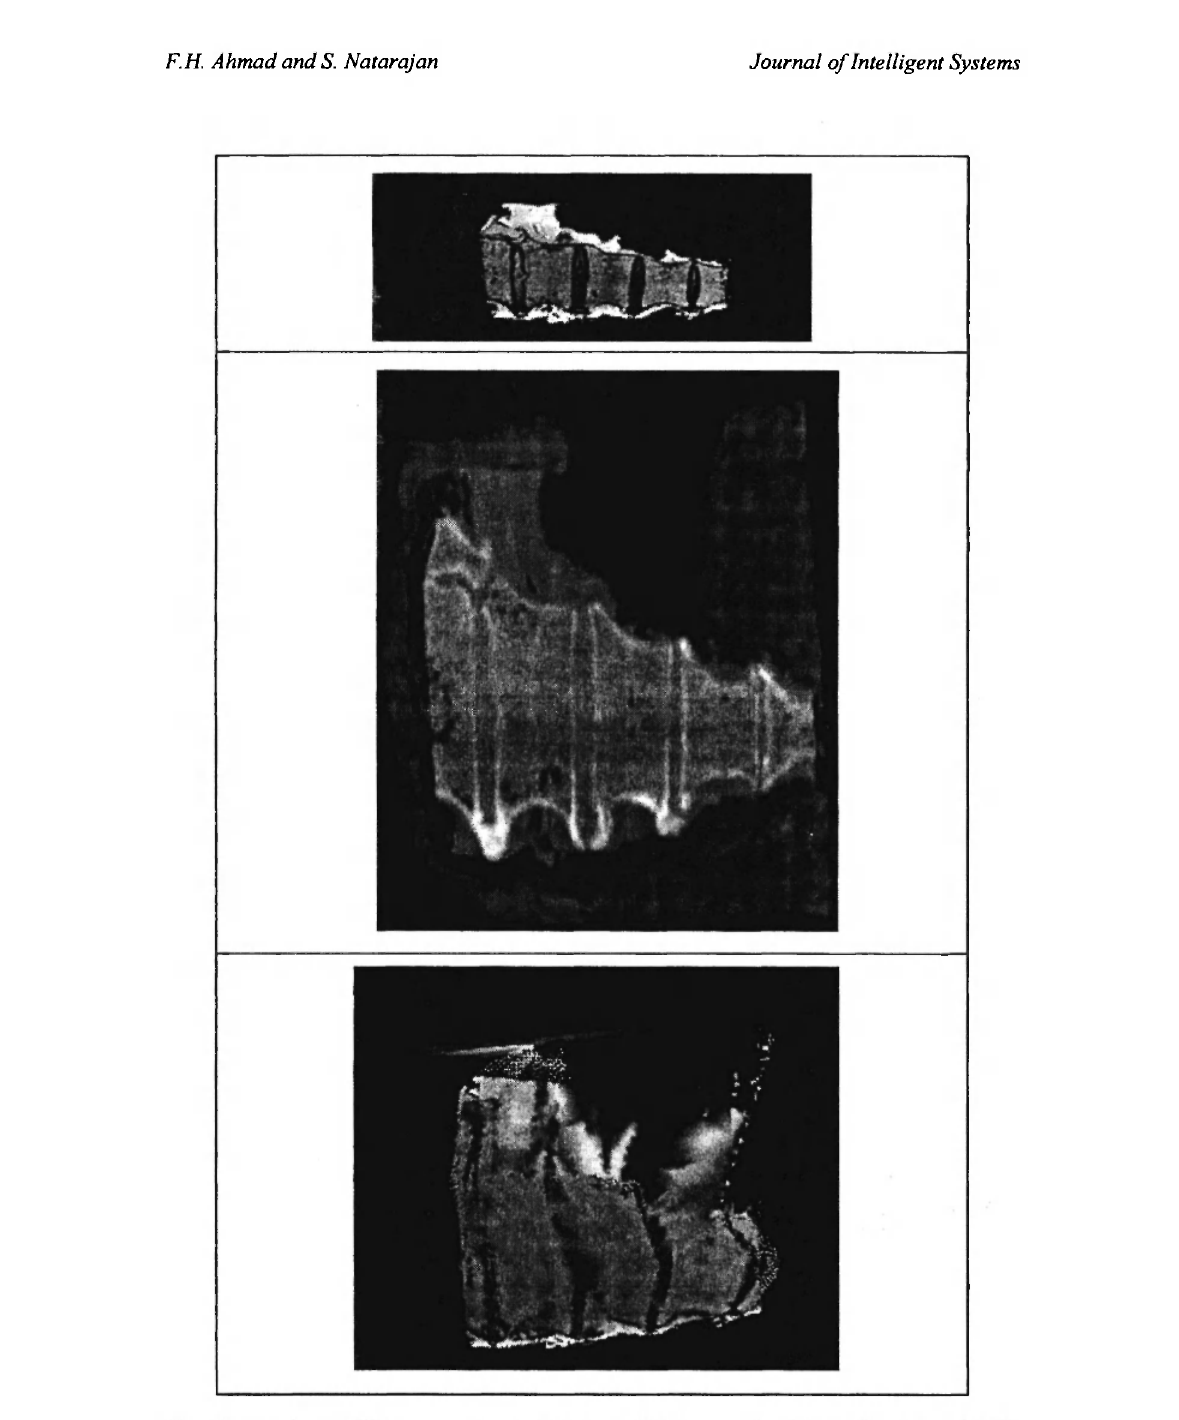
Fig. 5: Original MR image (top), Original CT image (middle), Registered MR image (bottom) obtained that has been deformed to match the CT image